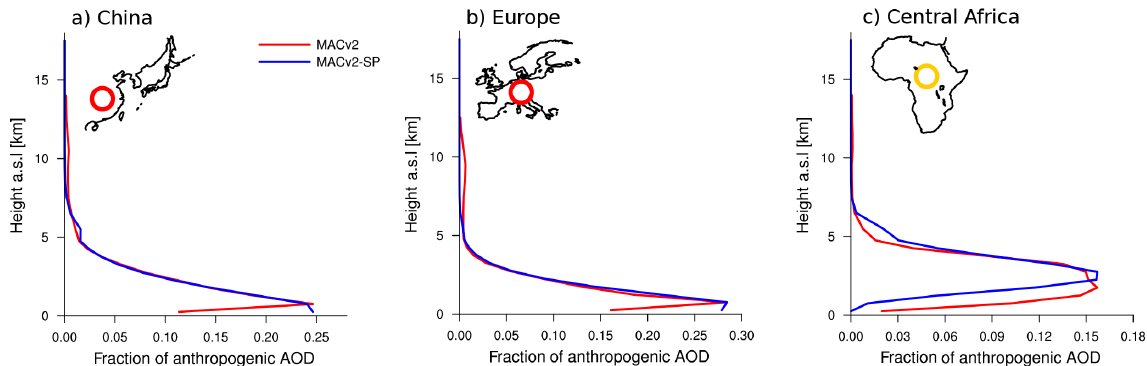
Figure 4. Vertical profile of fractional aerosol optical depth (550nm) from MACv2-SP with respect to the column integral at each location (x,y) . Shown by the blue lines are b i values (i.e., the fraction of the AOD) for the east Asian, European and central African plume; red is the distribution taken from MACv2.